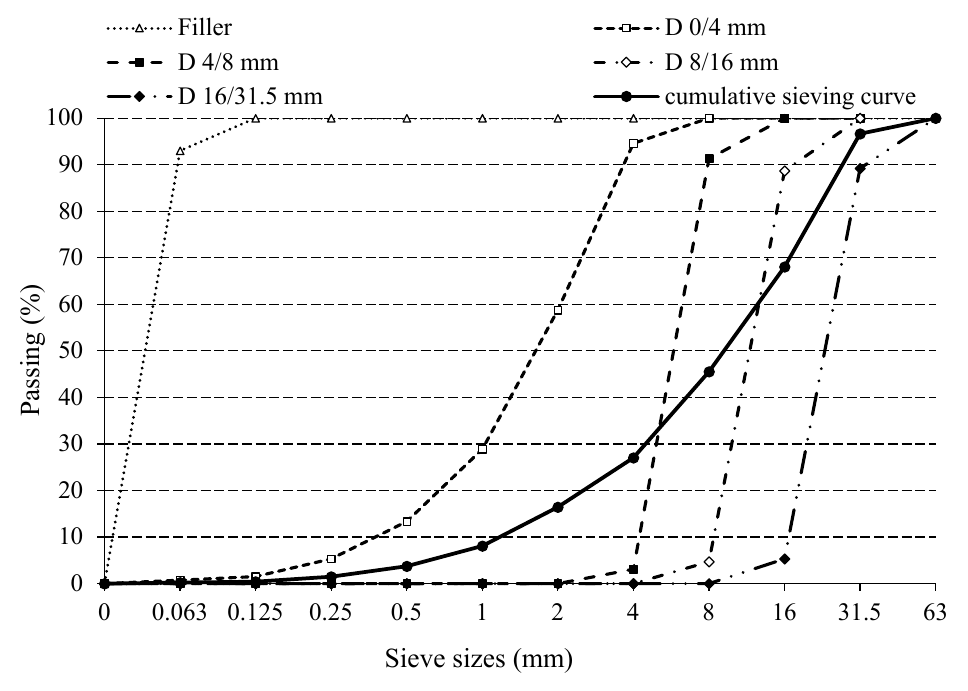
Figure 2. Particle size distribution of the aggregate .